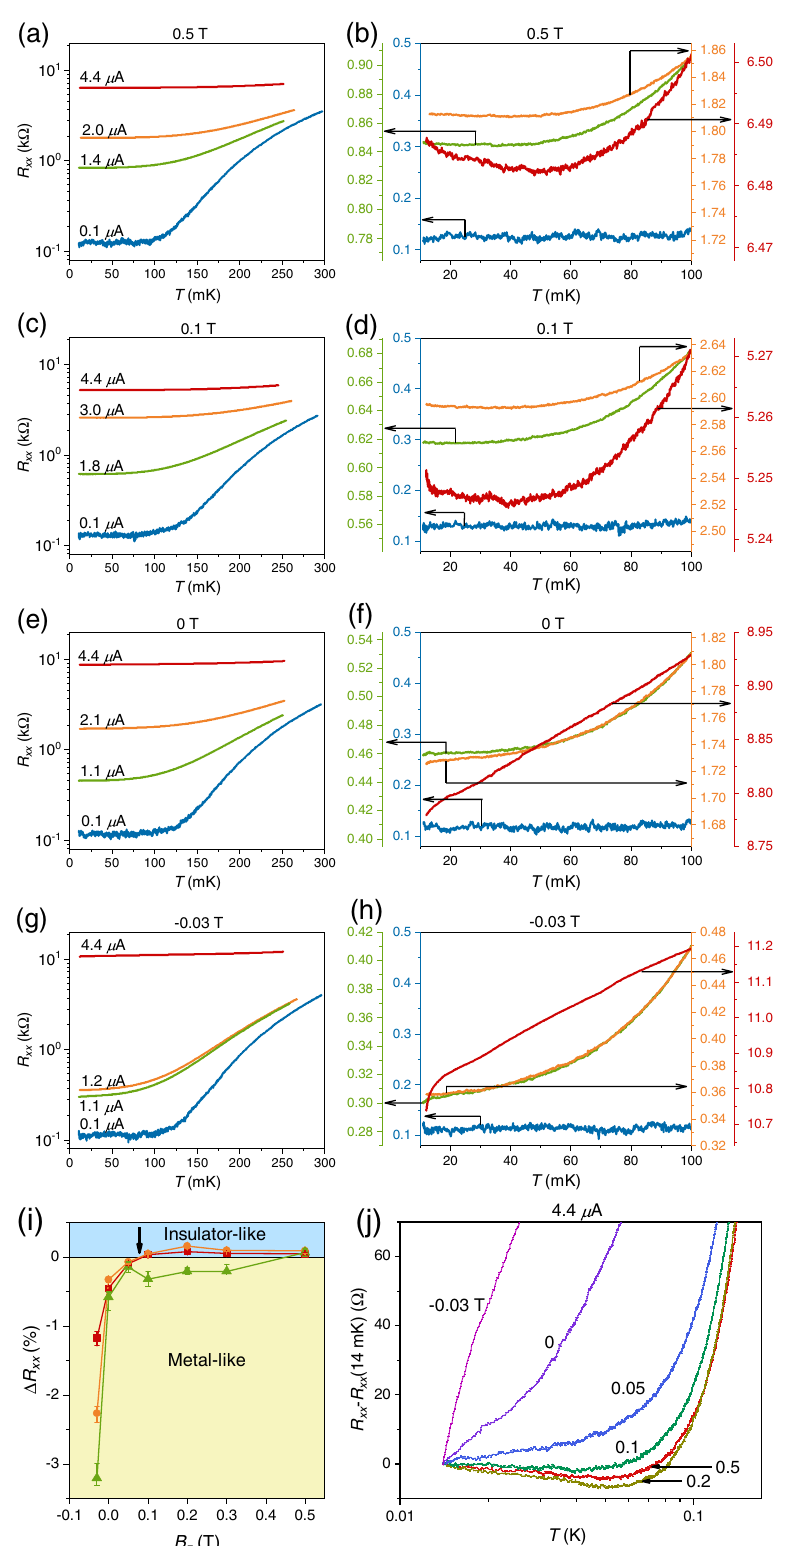
Fig. 4 Exotic “ insulator ” -to- “ metal ” transitions manipulated by the applied current and magnetic fi eld. a – h Longitudinal resistances ( R xx ) as functions of T obtained by using different I and B fi ne-scale plots of a , c , e , and g with respective R (cid:4) (cid:5) z . Note that b , d , f , and h are xx scale (multiple vertical axes). i The ratio = R ð Þ vs . B 4 R – h with the same color code. The light of change in R xx de fi ned as 4 R xx ¼ R xx 14mK ð Þ (cid:2) R xx 40mK ð Þ xx 40mK z , where xx are extracted from a yellow and blue regimes stand for the metal-like and insulator-like phases respectively, and the black arrow indicates the critical B z . ( j ) The modulated longitudinal resistances R xx (cid:2) R xx 14mK ð Þ vs . log ð T Þ plot by applying ~4.4 μ A dc current under different B z